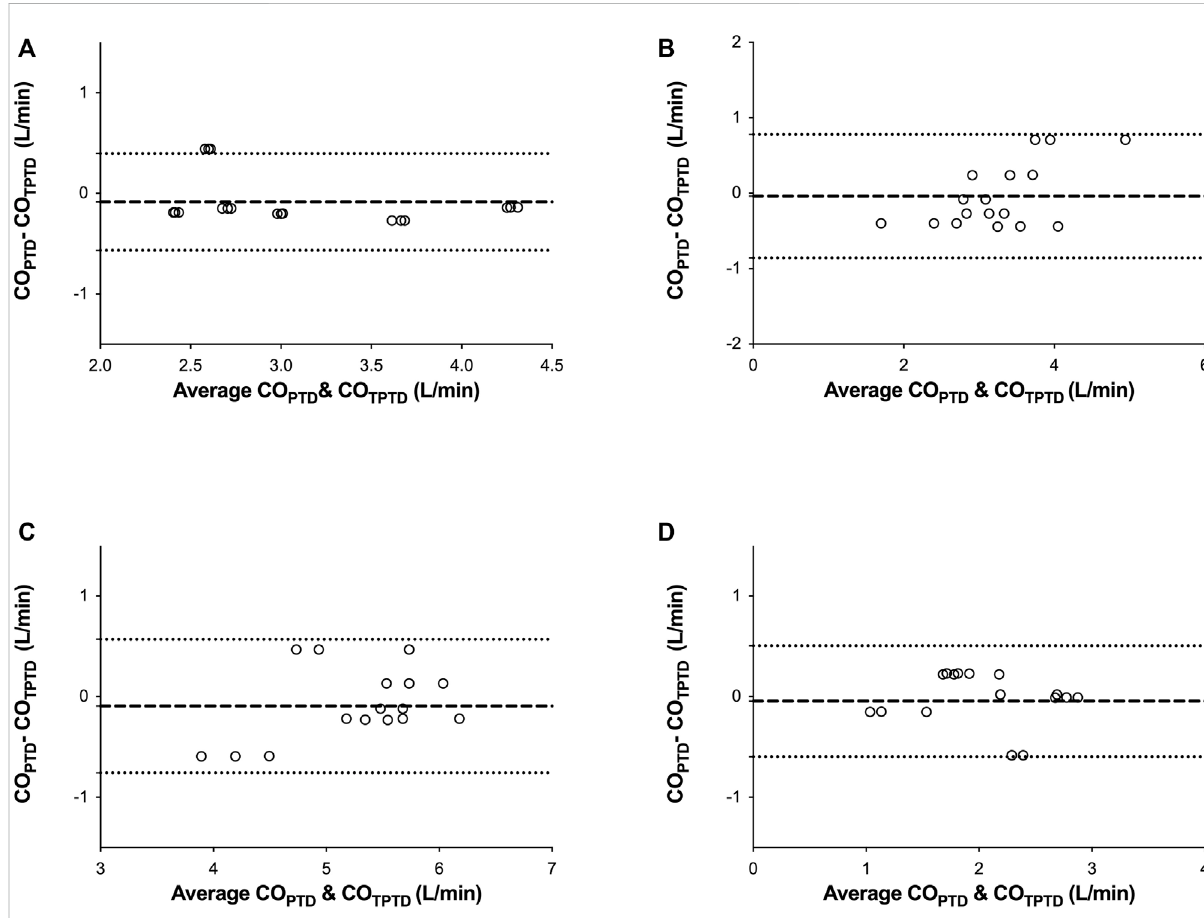
FIGURE 2 Correlation betweenthecardiacoutput(CO)measurements obtained bytranspulmonarythermodilution(CO TPTD )andintermittentpulmonary artery thermodilution (CO PTD )in four consecutive moments ofthe study: before starting theleft ventricular assist devices (LVADs) (A) , with the LVAD started in normovolemia (B) , hypervolemia ( fl uid overloading) (C) , and hypovolemia (shock hemorrhage) (D)